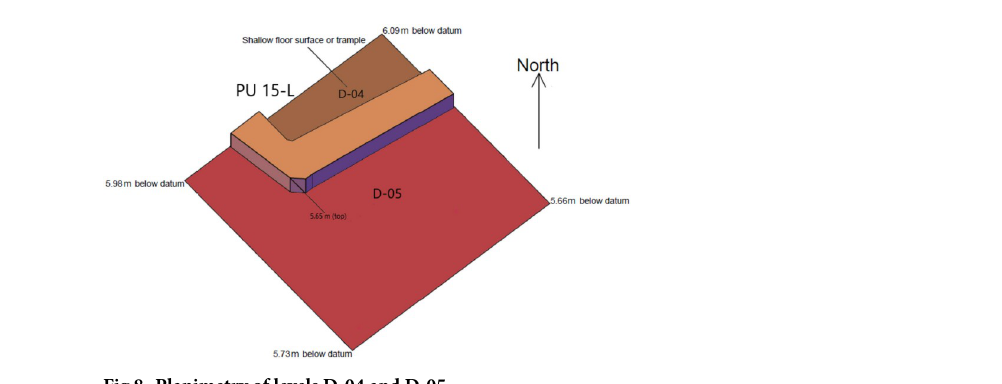
Fig 8. Planimetry of levels D-04 and D-05.